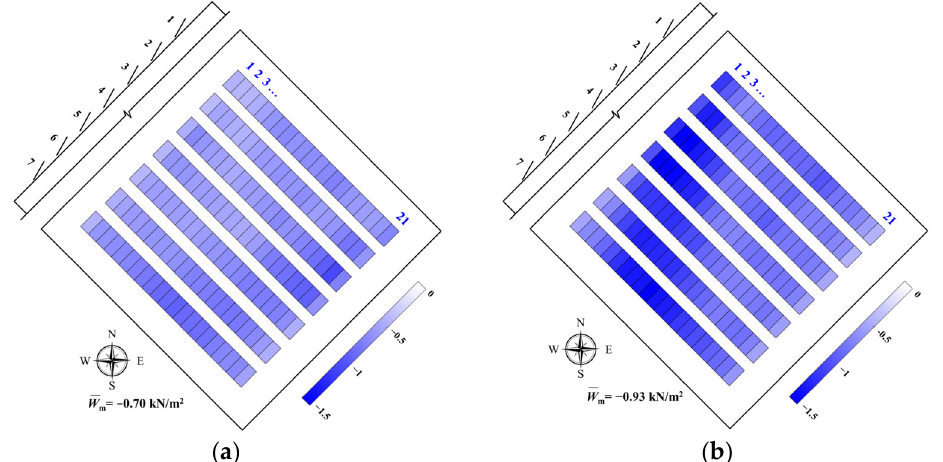
Figure 12. Distributions of extreme wind loading W m of solar arrays with building orientation α = 45° in different regions: ( a ) Jinan, China; ( b ) Beijing, China.